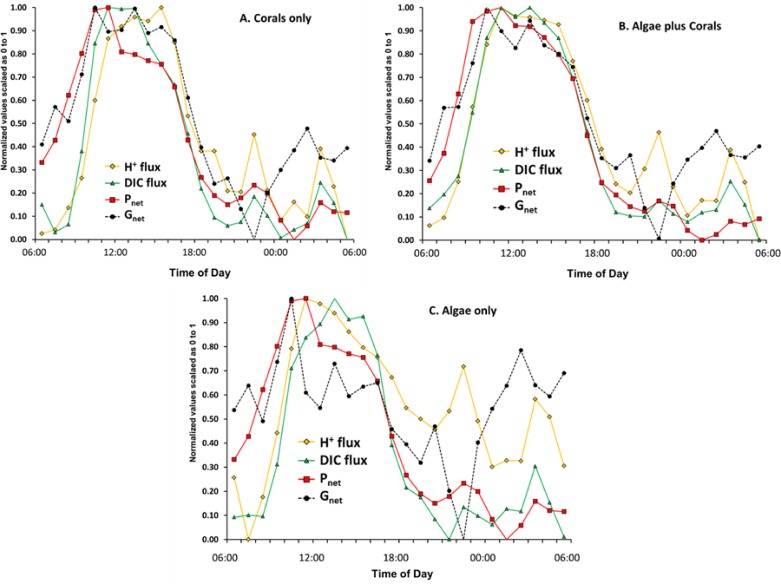
Plot of normalized data for Pnet, Gnet, inverse DIC flux and H+ flux for the experiment.